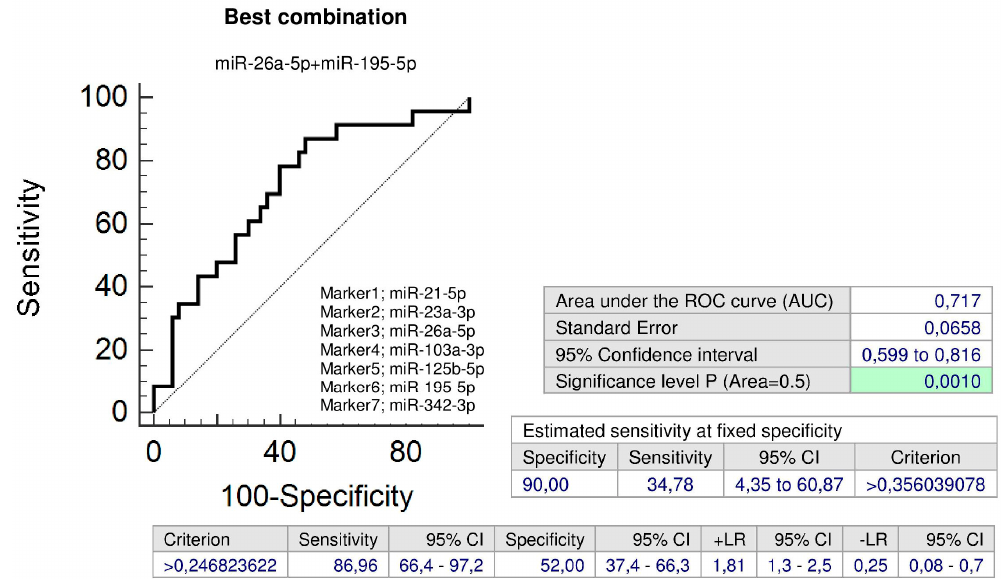
Figure 4. Combined postnatal screening of microRNAs in the identification of children with normal postnatal clinical findings descending from GH pregnancies. Postnatal combined screening of miR- 26a-5p and miR-195-5p showed the highest accuracy for the identification of children with normal clinical findings with a prior exposure to GH at a higher risk of later development of cardiovascular/cerebrovascular diseases.